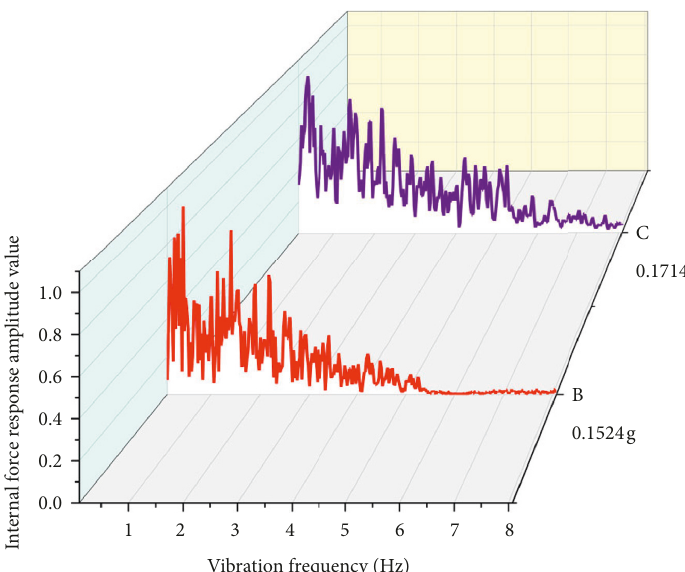
Figure 19: Vibration spectrum curve of pile